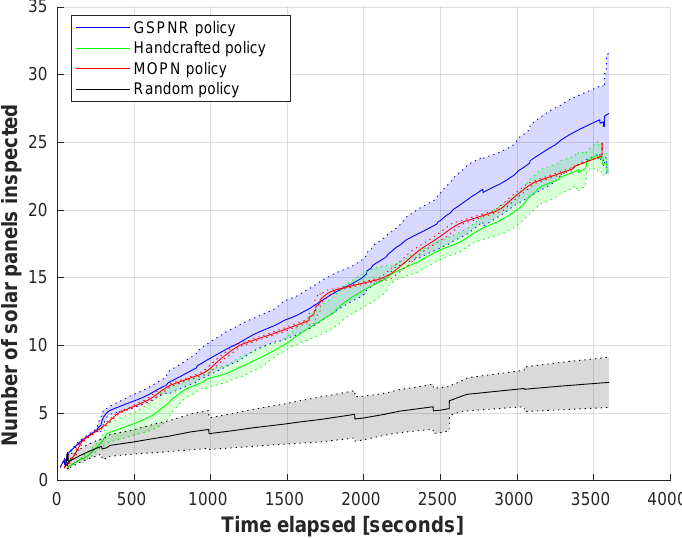
Figure 15. Number of panels inspected by each policy as time progresses. The solid line represents the average value over 8 runs and the shaded area the standard deviation.